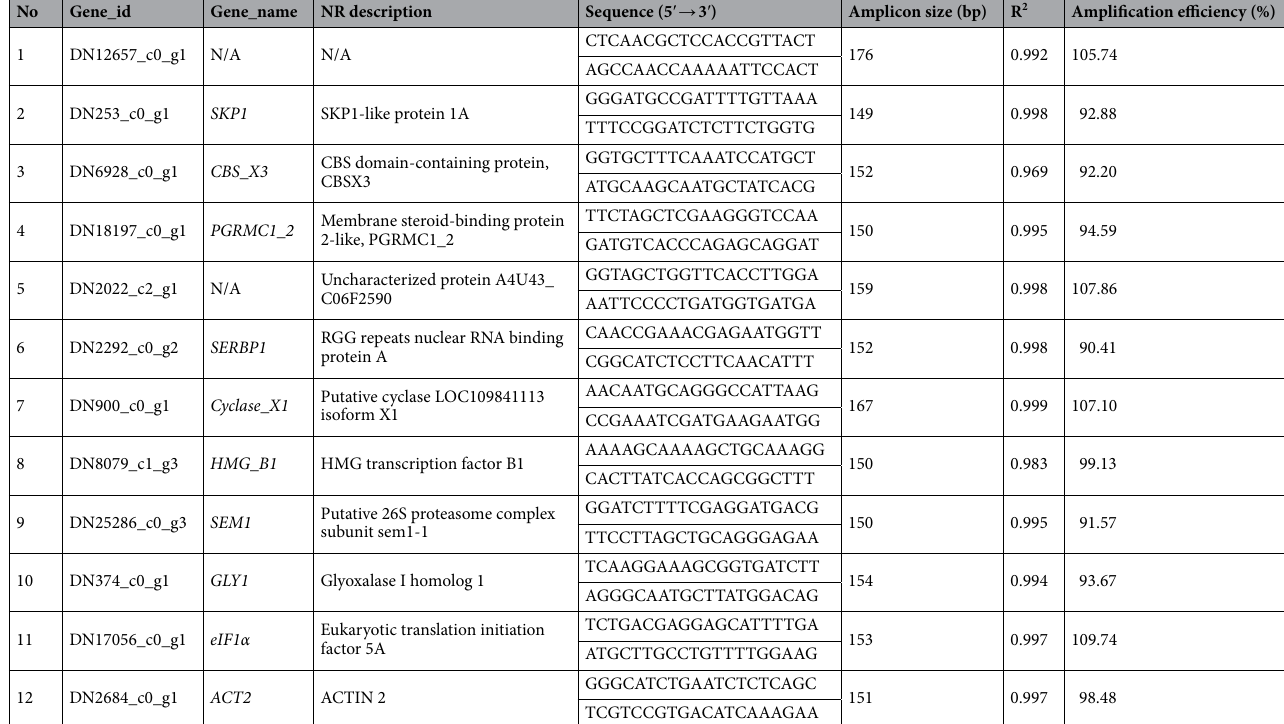
Table 1. Details of primers and amplicons of 12 candidate reference